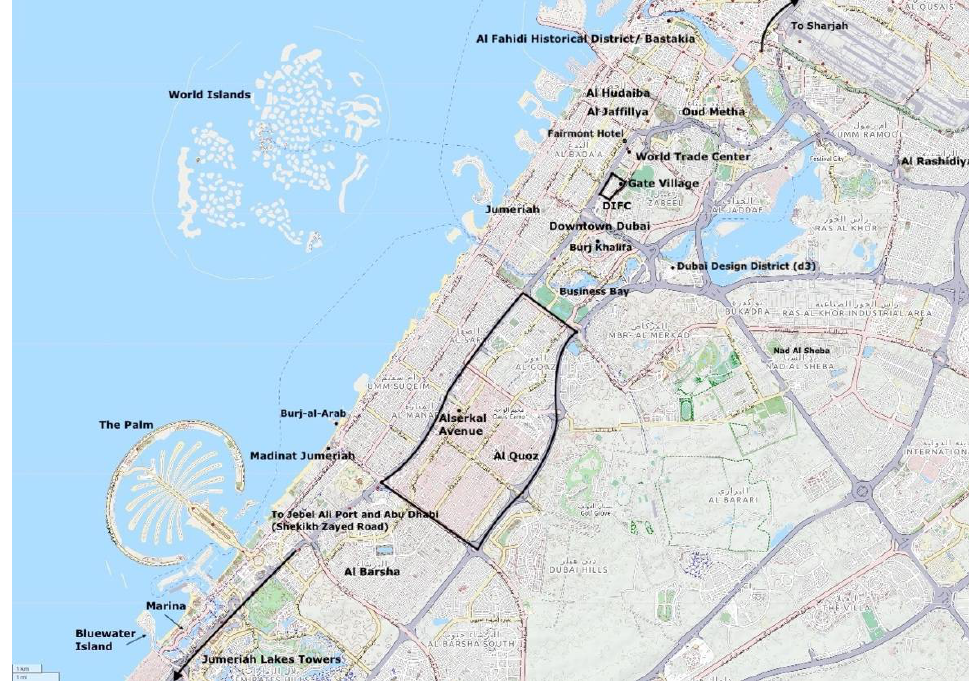
Figure 3. Map of Dubai indicating various neighbourhoods or buildings associated with the